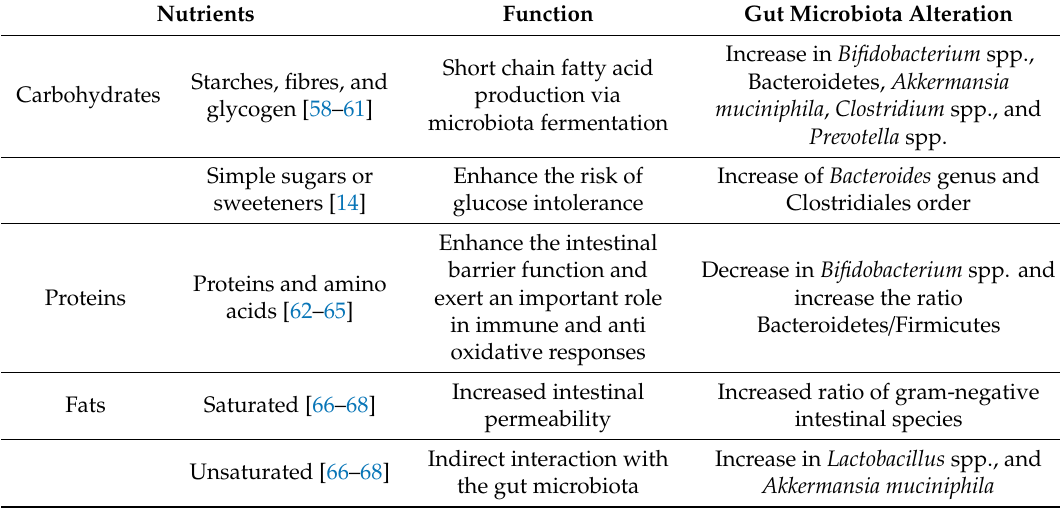
Table 1. Association between diet and potential microbiota